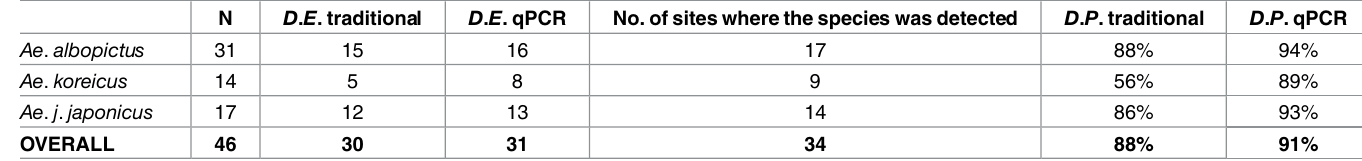
Table 1. Numberof detectionevents ( D . E .)and detectionprobabilities ( D . P .)withtraditional survey (larvalsampling)and qPCR for the threestud- ied invasive mosquitospecies(IMS),in the 46 waterbodieswherebothmethods have been applied. N: numberof sites analyzed. N